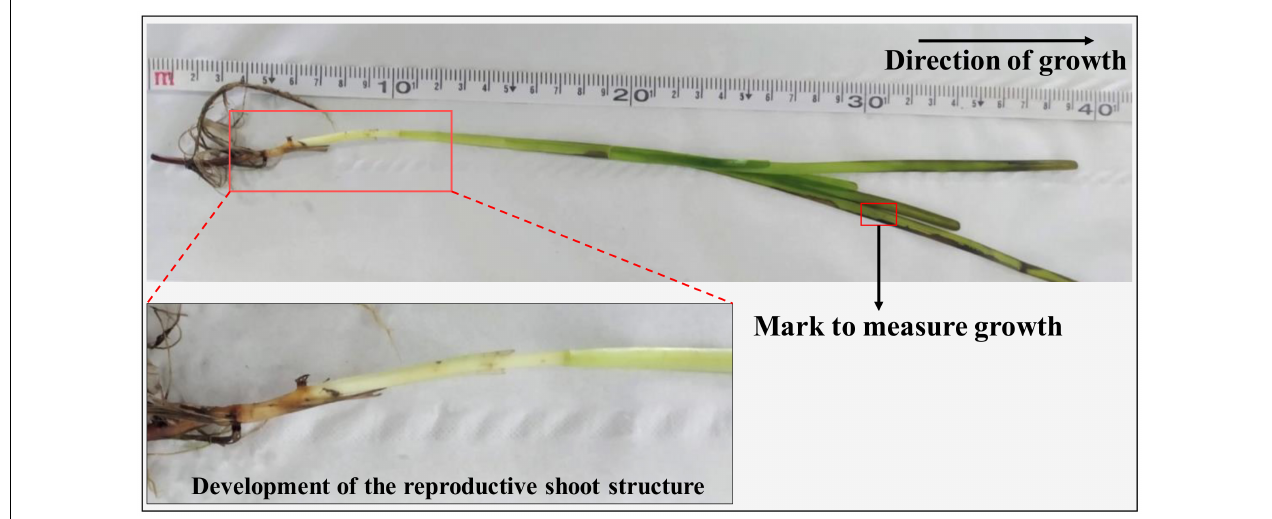
FIGURE 6 | Plant of Zostera marina incubated in January in high light (180 µ mol photons m − 2 s − 1 ) and 12 ◦ C showing first stages of reproductive structures. The direction of growth and growth marks are indicated in the